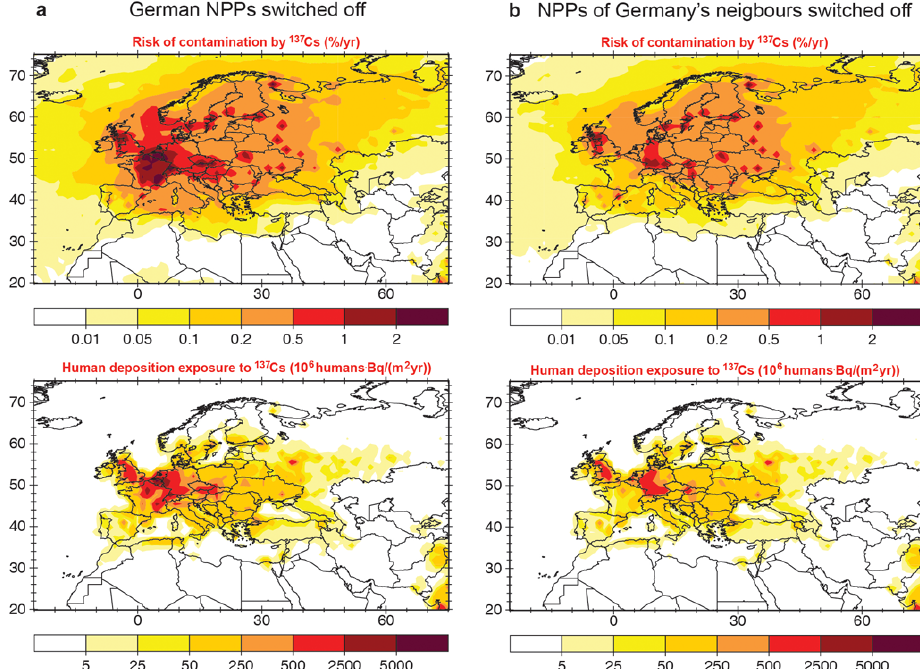
Fig. 10. Phasing out nuclear power plants. (a) Same as Fig. 3b, indicating the regional risks of contamination by 137 Cs with German reactors switched off. (b) Same as Fig. 3b with reactors in the neighbouring countries of Germany switched off (i.e., France, Belgium, the Netherlands, Switzerland and the Czech